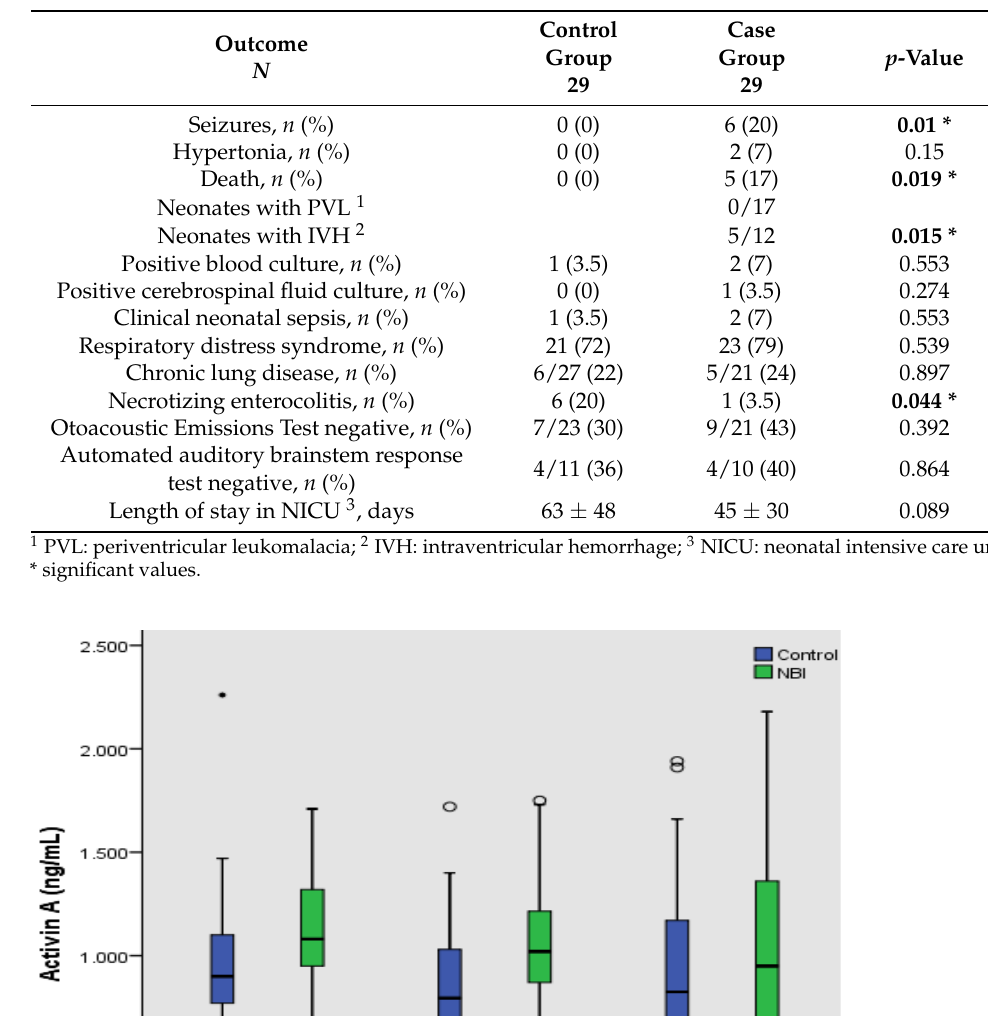
Table 4. Neonatal outcomes of control and case group neonates [22].